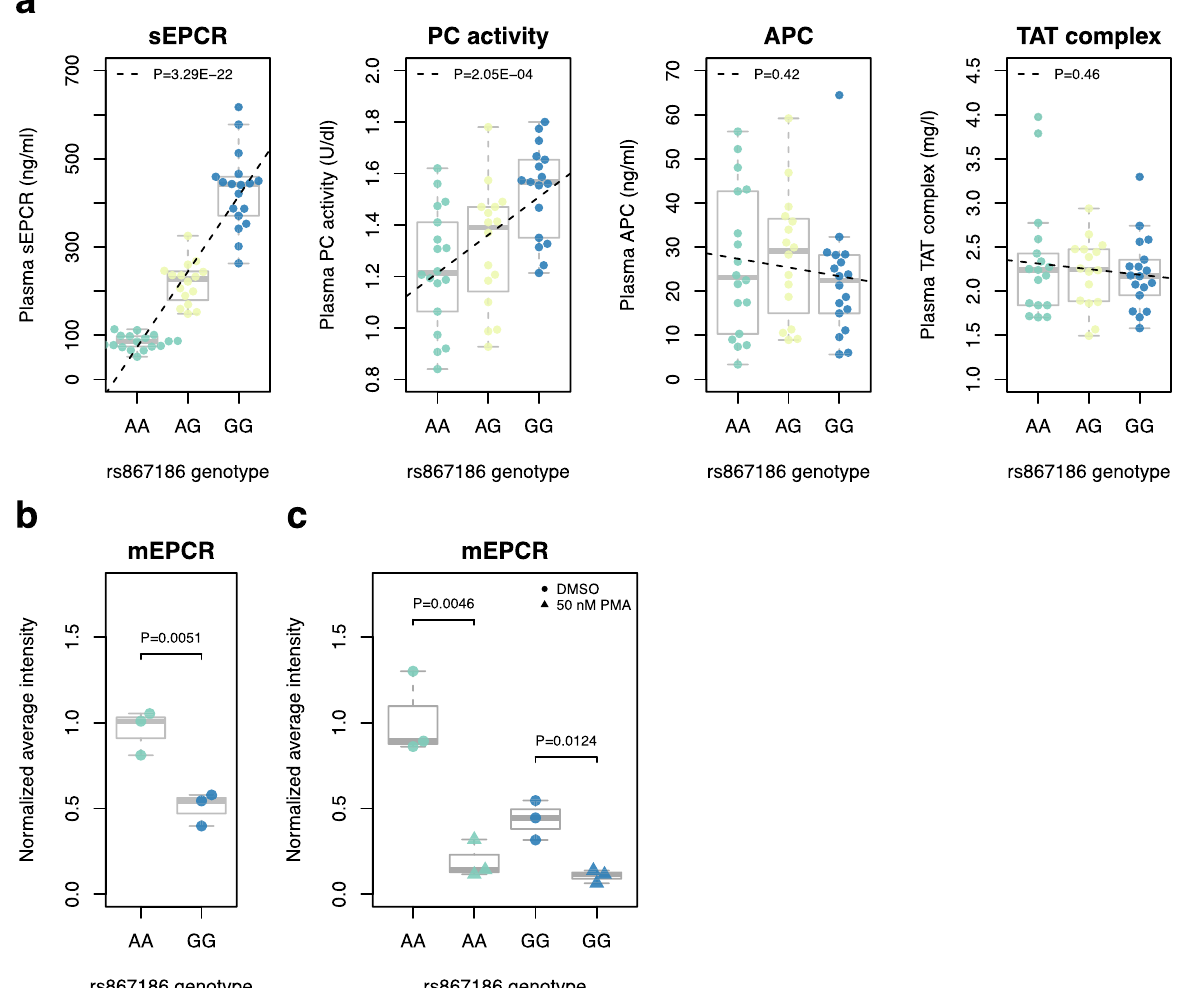
Fig. 4 Effect of rs867186 genotype on plasma biomarkers and EPCR expression on HUVECs. a Boxplots showing the distribution of plasma biomarker levels as a function of rs867186 genotype in up to 52 individuals. We measured plasma levels of sEPCR ( n = 52 individuals across the three genotypic groups), APC ( n = 52) and TAT complex ( n = 51) using immunoassays, and PC levels ( n = 51) using a chromogenic assay. All measurements were done with three technical replicates. The boxplots show the interquartile range in the box with the median as a horizontal line. Whiskers extend to ±1.5 times the interquartile range. Dashed lines indicate the fi tted linear regression model for biomarker~genotype. P values for the additive regression model are indicated. b Boxplots showing the distribution of EPCR levels on HUVECs homozygous for the rs867186-G-allele or A-allele ( n = 3 cell lines per genotypic group). Data show mean fl uorescence intensity values of EPCR on untreated HUVECs, normalized to mean fl uorescence intensity values of homozygotes of the rs867186-A-allele. The boxplot shows the interquartile range in the box with the median as a horizontal line. Whiskers extend to ±1.5 times the interquartile range. P values were calculated using a one-tailed t -test. c Boxplots showing the distribution of EPCR levels on HUVECs homozygous for the rs867186-G-allele or A-allele ( n = 3 cell lines per genotypic group). Data show mean fl uorescence intensity values of EPCR on HUVECs simulated with DMSO (vehicle control) or 50 nM phorbol 12-myristate 13-acetate (PMA), normalized to mean fl uorescence intensity values of homozygotes of the rs867186-A-allele. The boxplots show the interquartile range in the box with the median as a horizontal line. Whiskers extend to ±1.5 times the interquartile range. P values were calculated using a paired one-tailed t -test. All experiments were performed with three technical replicates per cell line. Membrane EPCR levels were quanti fi ed using fl ow cytometric analysis (Methods). Bold lines and boxes represent the median and interquartile range of the data,